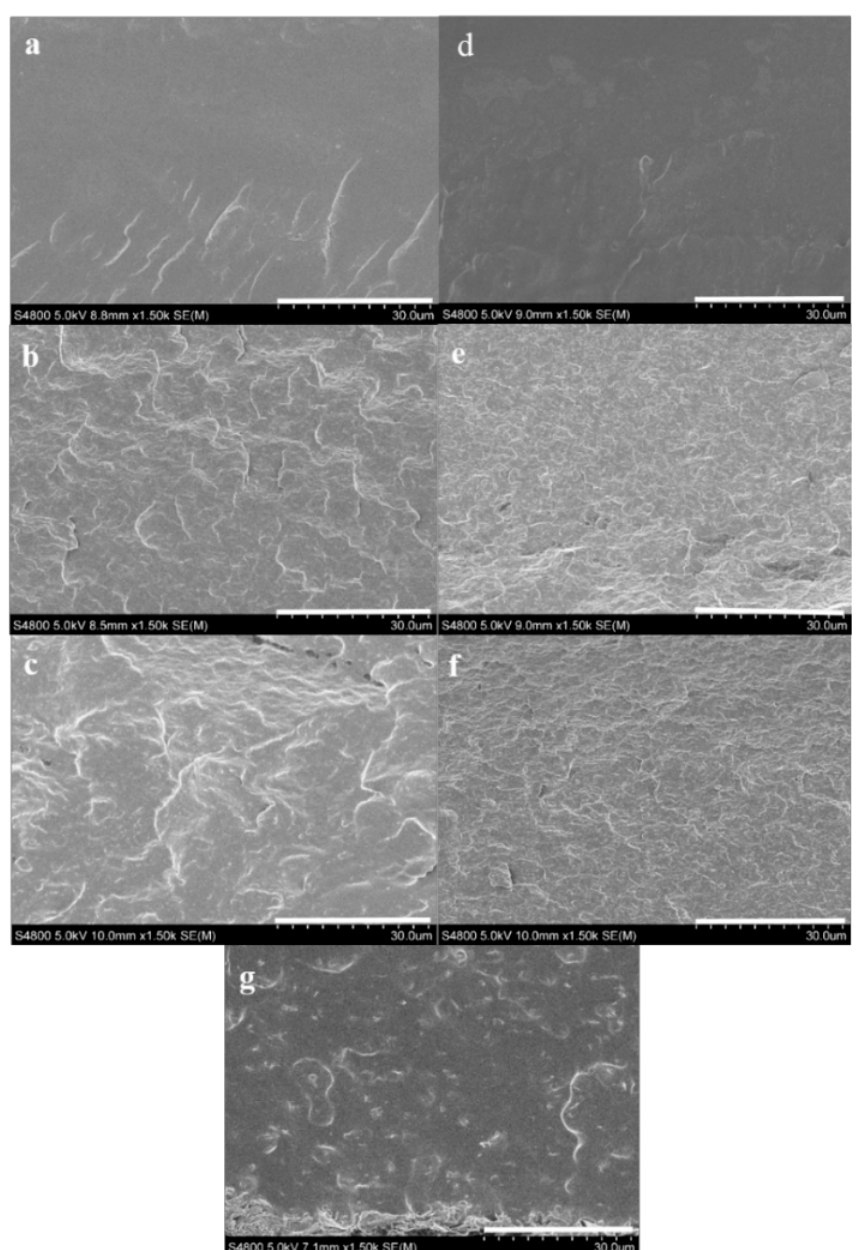
Figure 4. SEM images of the fractured surfaces of: ( a ) PVA; ( b ) PVA/GS1; ( c ) PVA/GS2; ( d ) PVA/GLY; ( e ) PVA/GS1/GLY; ( f ) PVA/GS2/GLY; and ( g ) PVA/GS1 ex situ.